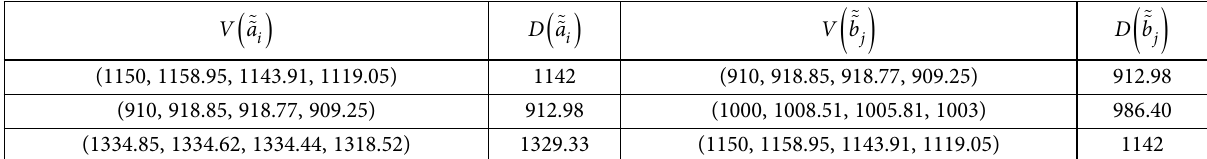
Table 6. Defuzzifucition of the T2TFN with T1TFN and crisp value of demand and supply